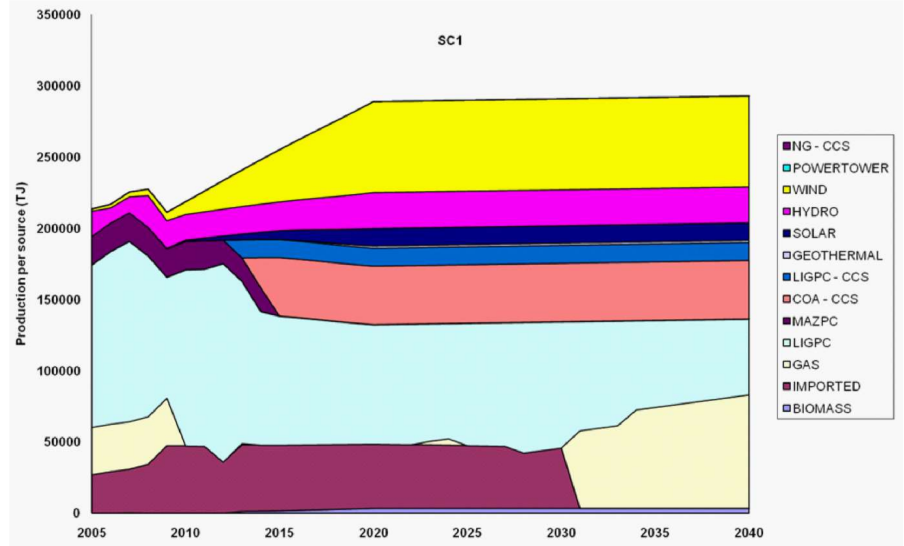
Figure 14. Electricity generation by technology groups, according to scenario SC1.